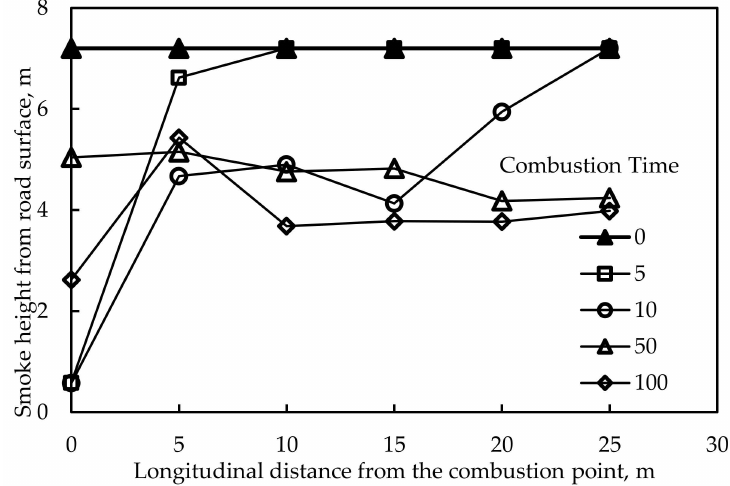
Figure 10. Smoke height distribution along the longitudinal direction (with fire